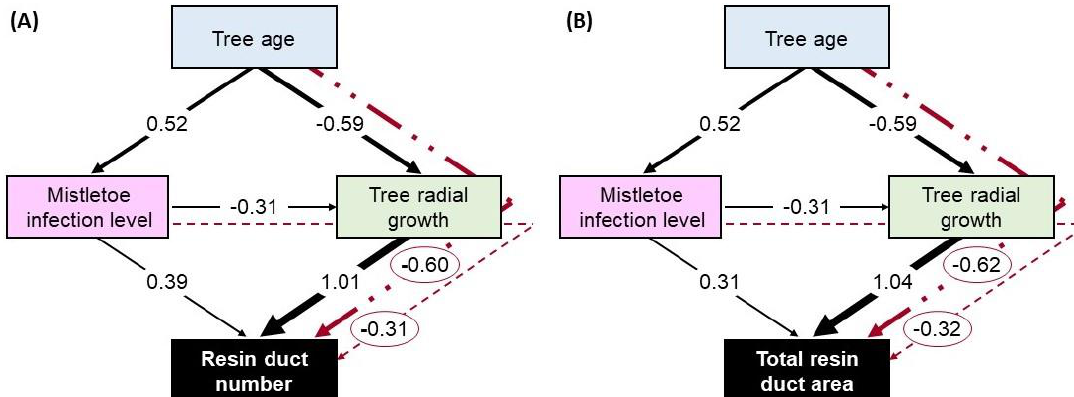
Figure 5. Structural equation model (SEM) results illustrating the direct (solid black lines) and indirect (dashed red line) effects of mistletoe infection, tree growth, and tree age on resin duct numbers (panel A) and the total cross-sectional area (mm 2 ) of resin ducts (panel B) within the five most-recent annual xylem-rings of lodgepole pines. The numbers are standardized coefficient values and the arrow sizes are scaled to support comparisons of relative influences among variables. Increasing levels of mistletoe infection have a positive influence on resin duct number and area that is countered by an indirect negative effect mediated by impacts of mistletoe infection on tree growth. All illustrated paths are considered significant ( p < 0.05).